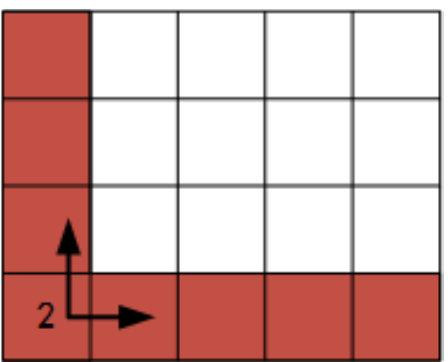
Figure 2. The problem is transferred to solving the Non-Uniformity Correction (NUC) for the first row and first column of the section.